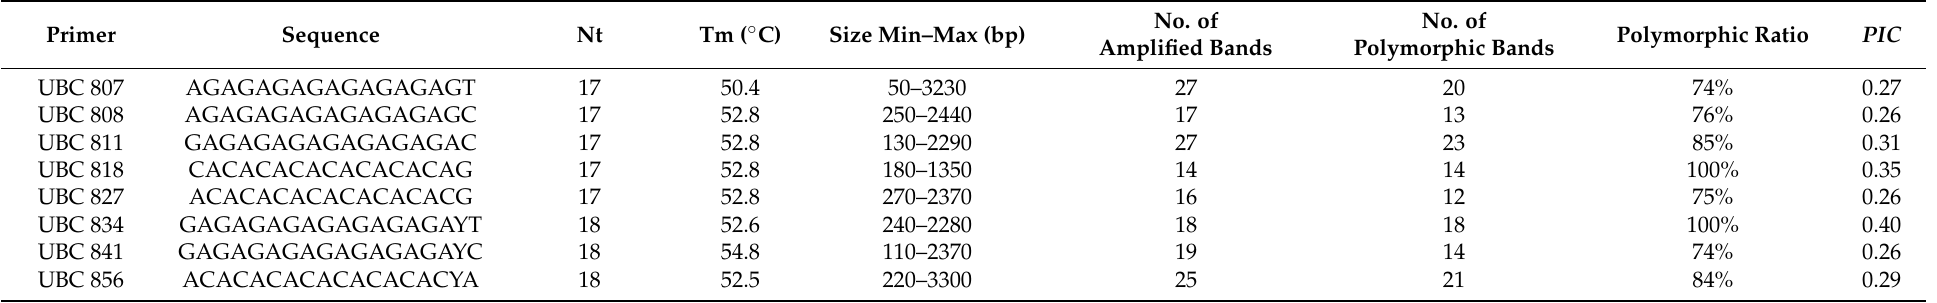
Table 4. Profiles of the eight selected inter simple sequence repeat (ISSR) primers (amplified and polymorphic bands, percentages of polymorphism, PIC values) used for the genetic analysis of the 20 genotypes of P. lentiscus var.